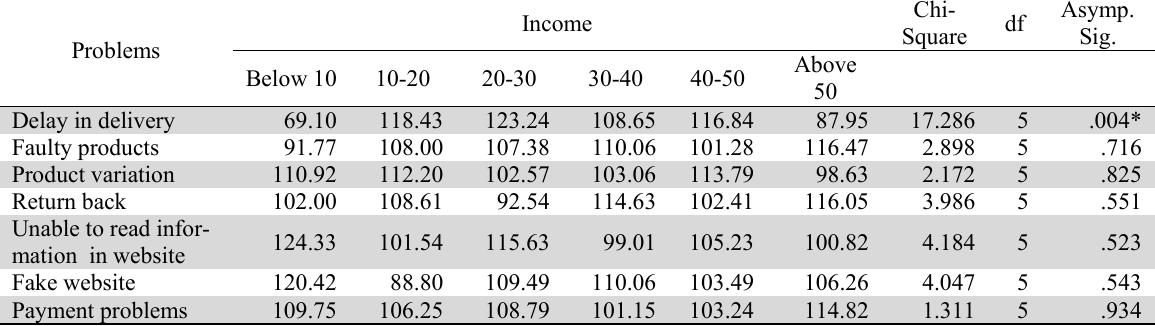
Results of Kruskal Wallis Test – Income Vs Ranking of Problems Problems